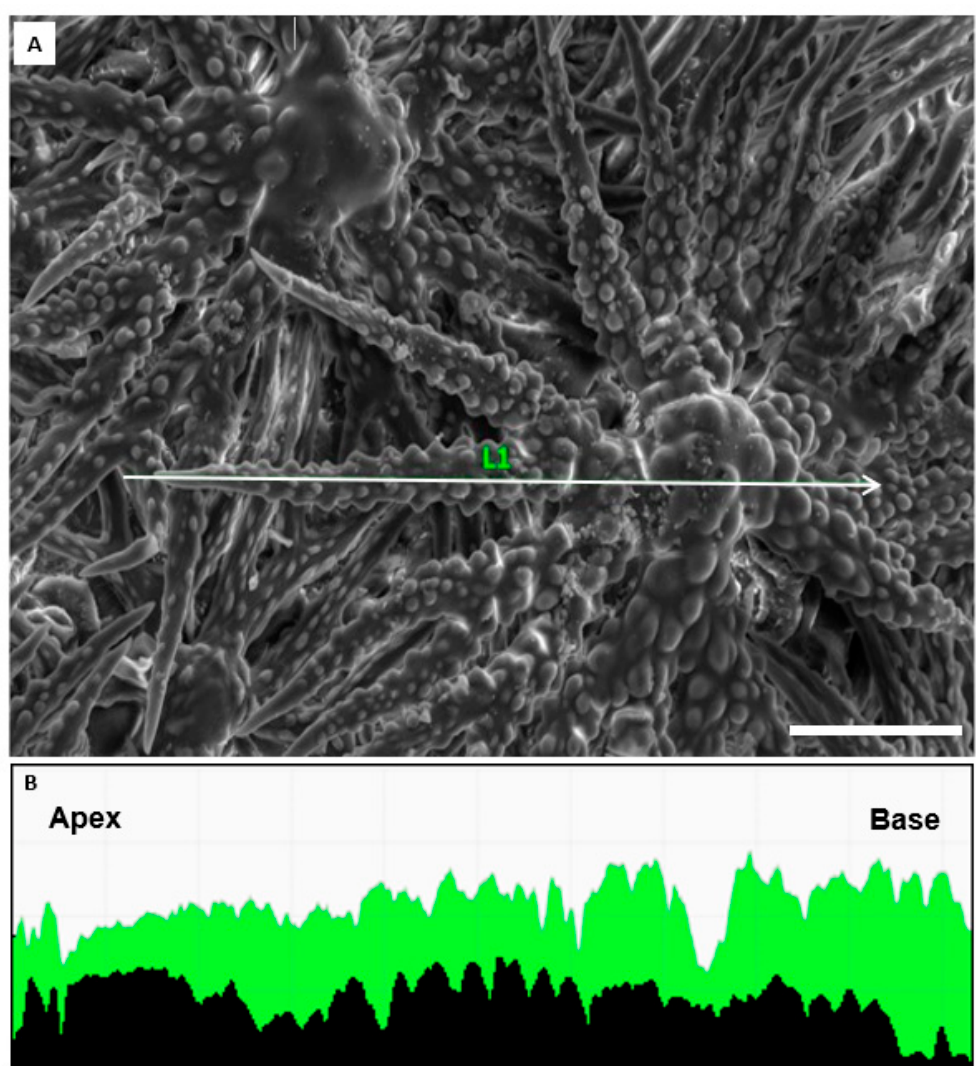
Figure 4. Odontarrhena stridii trichome analysis (collected from serpentine soil in Greece; Selvi & Bettarini, FI-055800, FI). ( A ). Secondary electron image of stellate trichome. ( B ). Energy-dispersive X-ray spectroscopy line scan results with the distribution of Ca (green) and Mg (black) illustrated from apex to base. The ratio of Mg to Ca for this selected branch averages to 1:2.88 in the apex, 1:2.44 in the shaft and 1:2.58 in the base. Scale bar: 50 µ